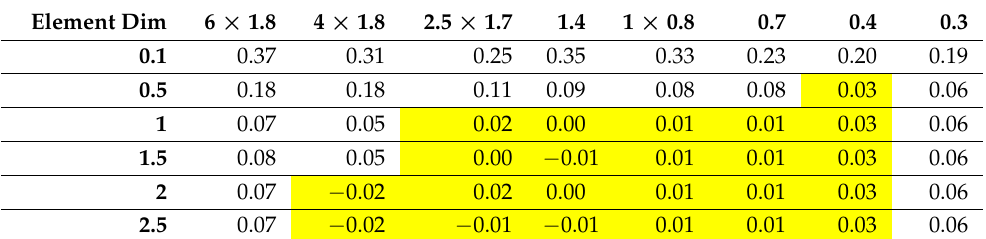
Table 11. The comparison between the two element sizes in the retopologised models with an adaptive size parameter of 100. The columns represent the size of the superficial element, and the rows represent sizes of the volumetric